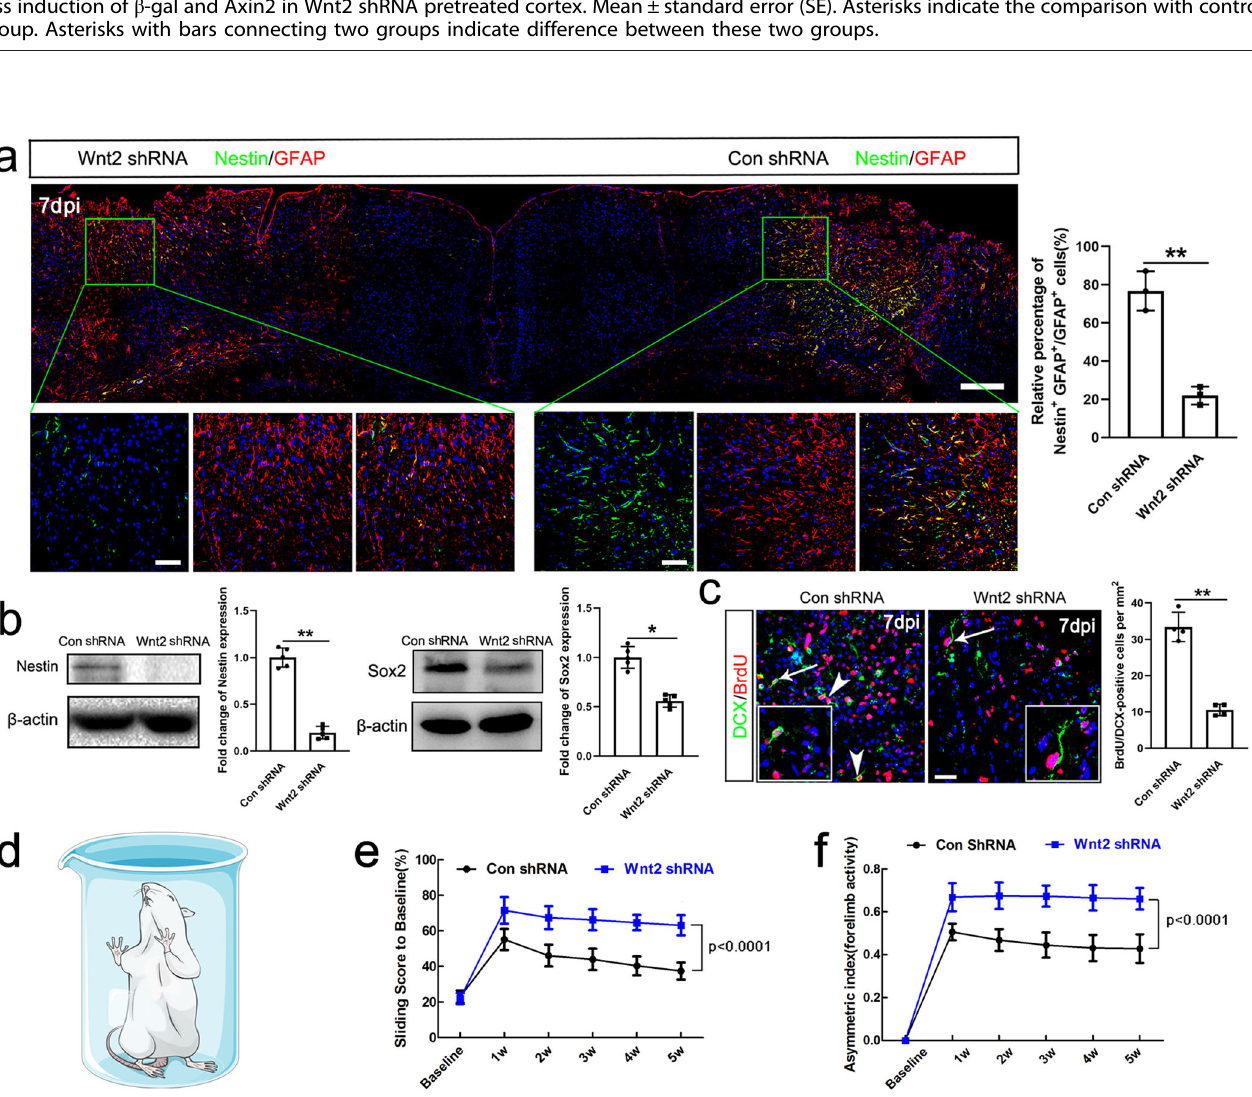
Fig. 3 Effects of Wnt2 knockdown on astrocyte dedifferentiation and cortical neurogenesis. a Representative images of Nestin/GFAP double-immunostaining in the bilateral cortice with two ischemic injures infected by lentivirus expressing control shRNA (right) and Wnt2 shRNA (left), respectively. Bars = 200 μ m in upper panel. Bar = 100 μ m in enlarged view. b Western-blotting of Nestin and Sox2 in Wnt2 shRNA treated mice at 7 dpi. Wnt2 shRNA dramatically suppressed the expression of Nestin and Sox2 without obviously affecting the expression of GFAP. N = 5 mice per group. c Double-immunostaining and quanti fi cation of DCX/BrdU in ischemic cortices treated by control shRNA or Wnt2 shRNA. Arrowheads point to double-positive cells. Arrows point to magni fi ed cells. Bar = 20 μ m. ** P = 0.0087. Two-tailed Student ’ s t test. N = 4 mice per group. d – f Forelimb activity assay of mice treated with control shRNA or Wnt2 shRNA. From 2 weeks on, the sliding scores and the asymmetric index of forelimb activity in Wnt2 shRNA treated group were much higher than control group, indicating worse functional recovery. N = 5 mice per group. P < 0.0001 (2w, 3w, 4w and 5w). Two-way RM ANOVA. a – c , asterisks with bars connecting two groups indicate difference between these two groups. e , f , P values indicate comparison of experimental group with control group of same time point. Mean ± standard error